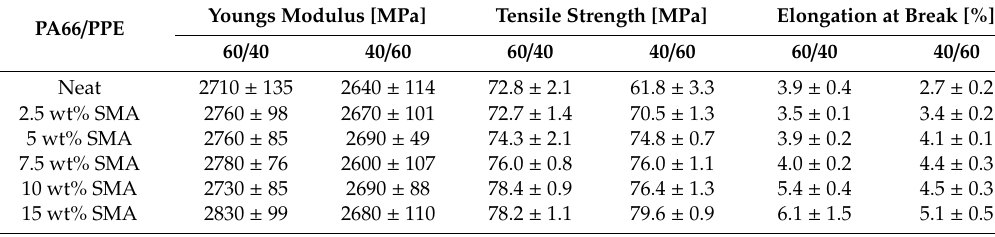
Table A2. Summary of the tensile performance for the PA66 / PPE / SMA ternary blends. PA66 /